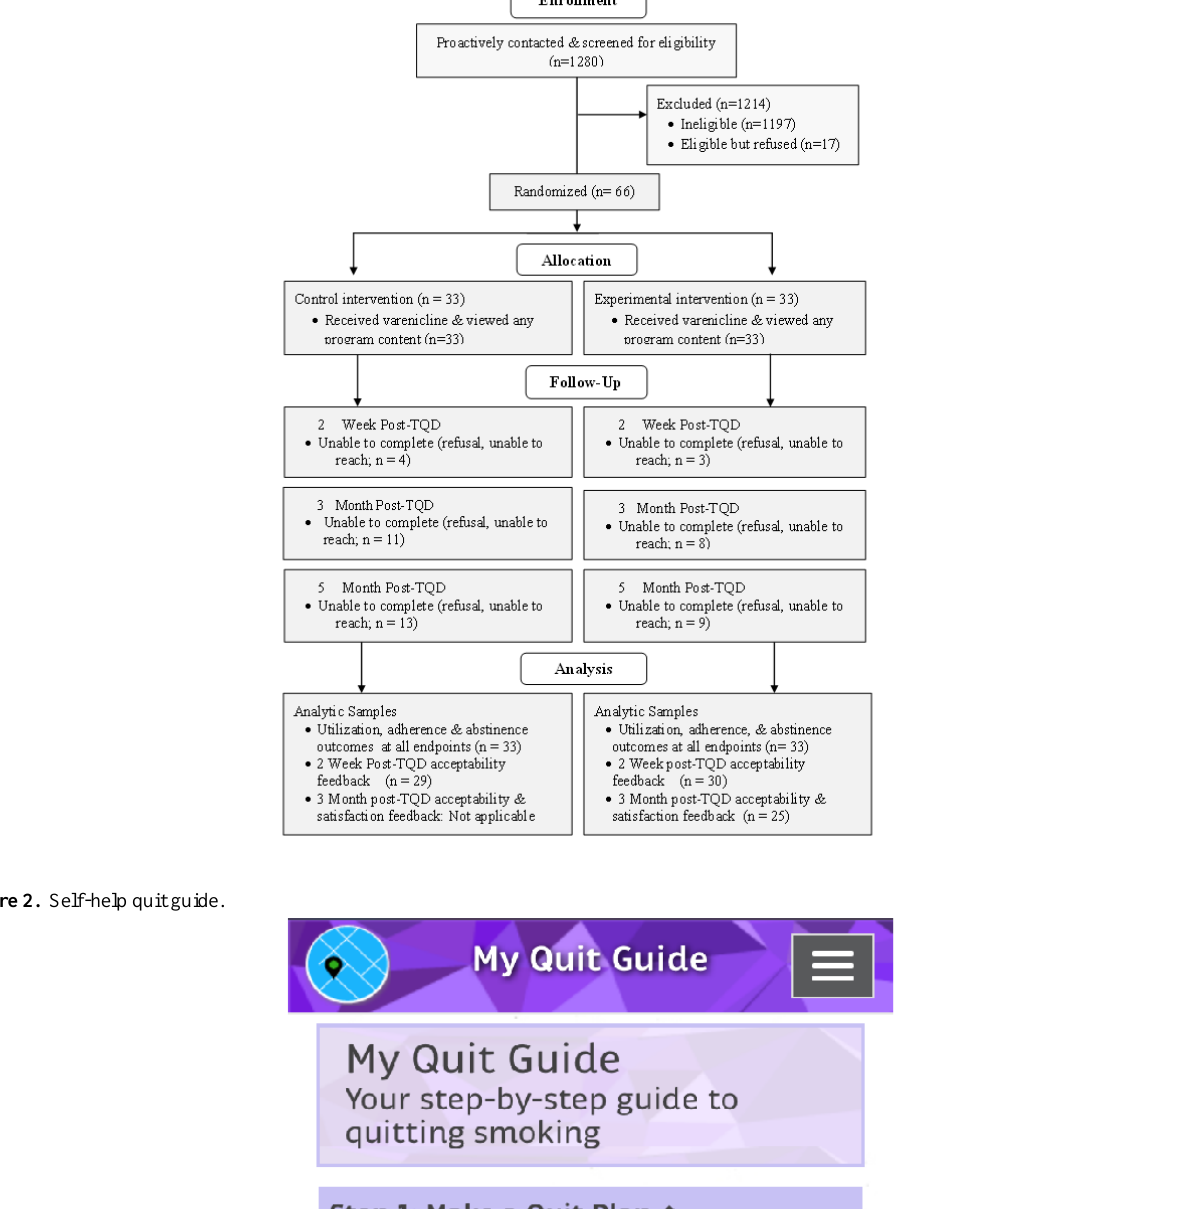
Figure 1. Enrollment flow.